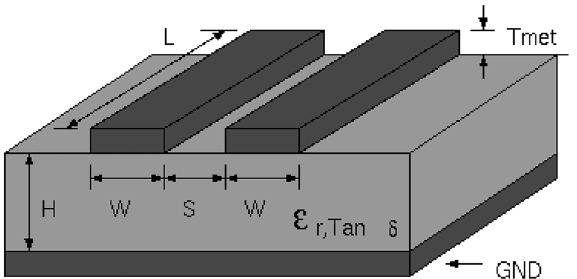
Figure 4. A microstrip as an example of physical realization of a coupled transmission line, with parameters W = 1.2 mm, S = 0.1 mm, H = 0.35 mm and substrate dielectric constant